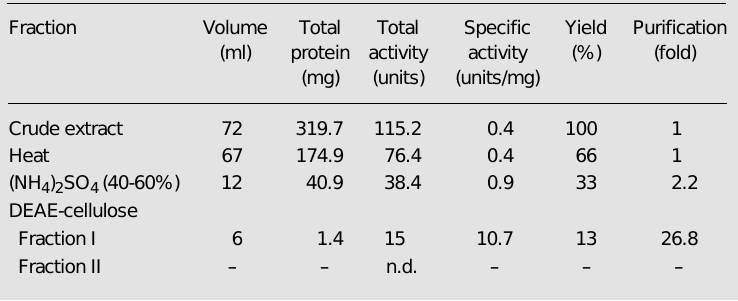
Table 3 - Partial purification of a constitutive alkaline phosphatase synthesized by the wild 74A strain of N. crassa grown in high-Pi medium at 30 o C, supplemented with 44 mM sucrose as the carbon source and buffered at pH 7.8 with 50 mM Tris-HCl. n.d., Not detected. For details, see Material and Methods.